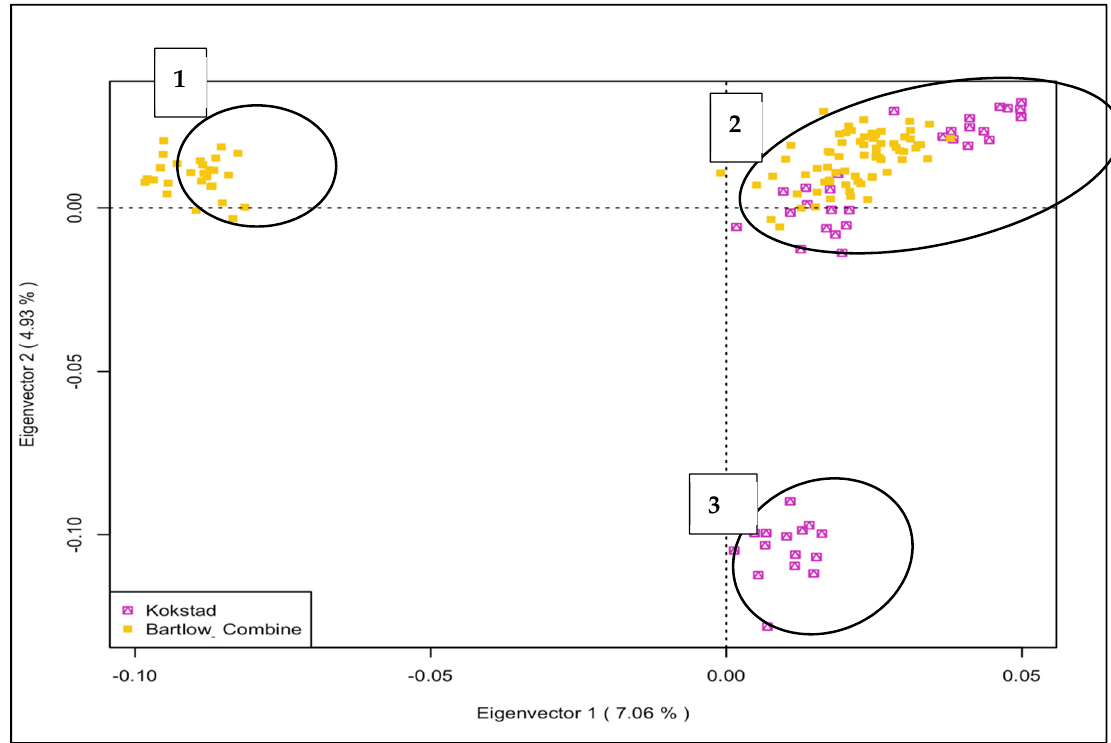
Figure 2. PCA − based clustering of Bartlow Combine and Kokstad Nguni cattle populations.